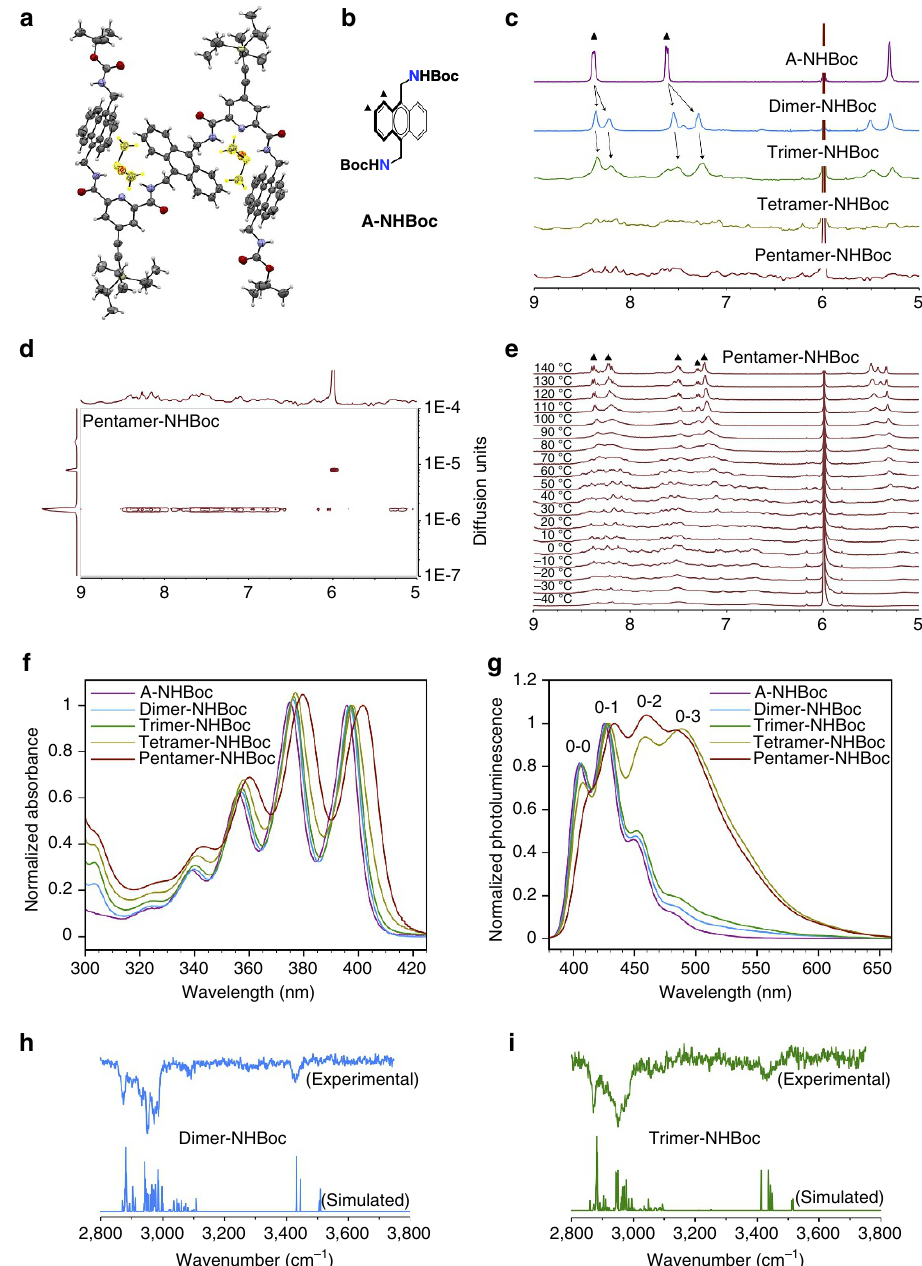
Figure 3 | Structural characterization of the foldamers. ( a ) Solid-state structure of trimer-NHBoc with two DMSO molecules (highlighted in yellow). ( b ) Chemical structure of A-NHBoc. ( c ) NMR spectra of the foldamer NHBoc series at 25 (cid:2) C. ( d ) Two-dimensional DOSY NMR of pentamer-NHBoc at 25 (cid:2) C. ( e ) VT-NMR of pentamer-NHBoc. ( f ) Absorption and ( g ) PL spectra of the NHBoc foldamer series at 25 (cid:2) C. Infrared ion dip spectrum of ( h ) dimer-NHBoc and ( i ) trimer-NHBoc. The triangles in b – e indicate the signals that correspond to anthracene